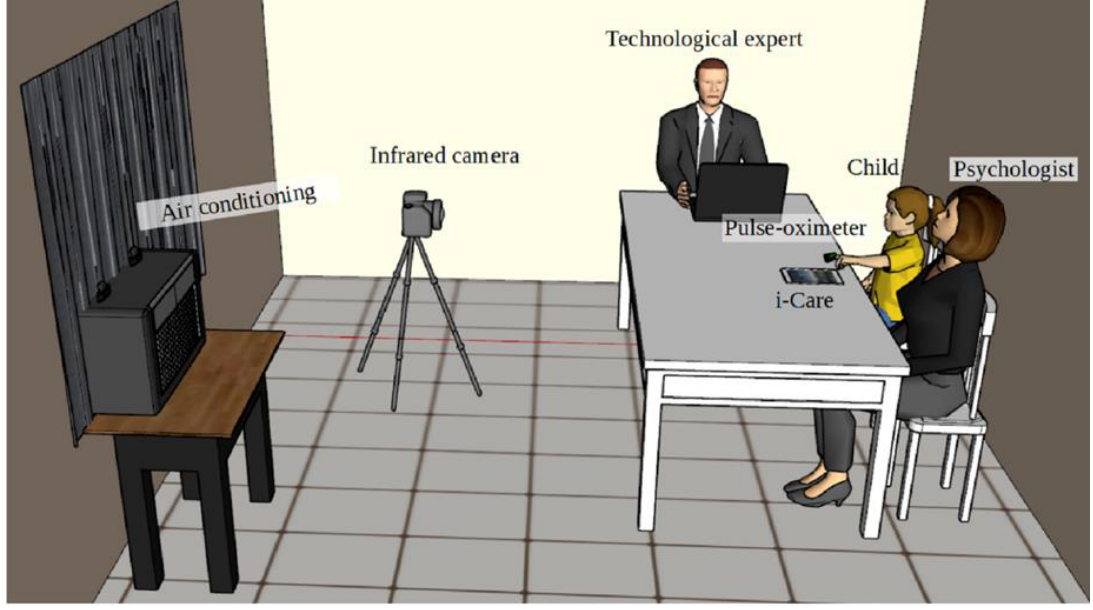
Figure 2. Conditioned space.